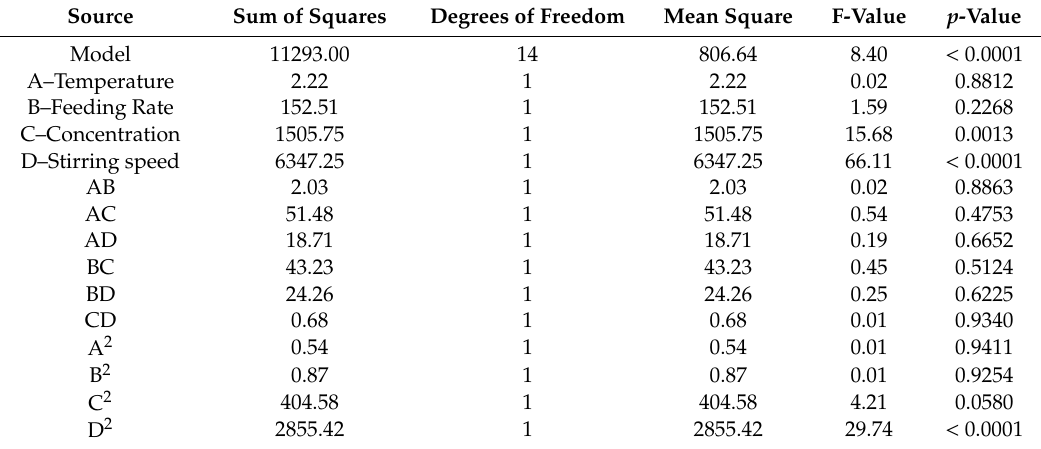
Table 8. ANOVA analysis and results with quadratic model of particle